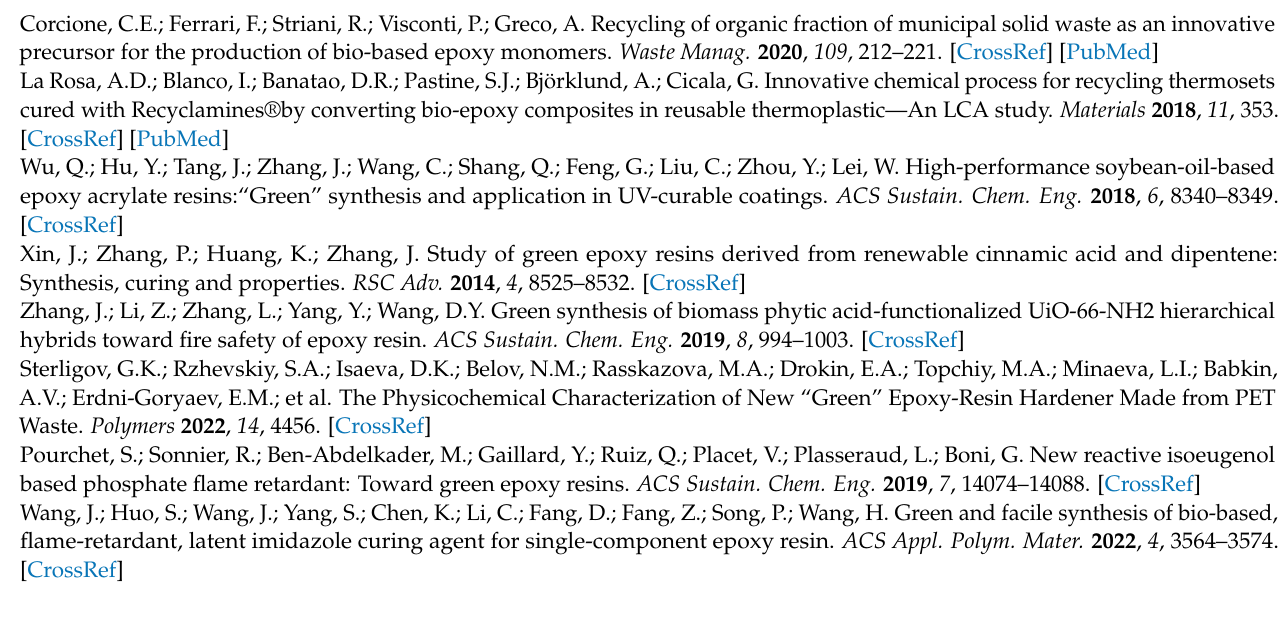
A. Figure S4: Microscope images of an uncured epoxy composition containing 5 and 10 wt.% of lignocellulosic filler in a form of unmodified/silanized oak or peanut shell flour. Figure S5: The analysis of the contact angle of the selected epoxy